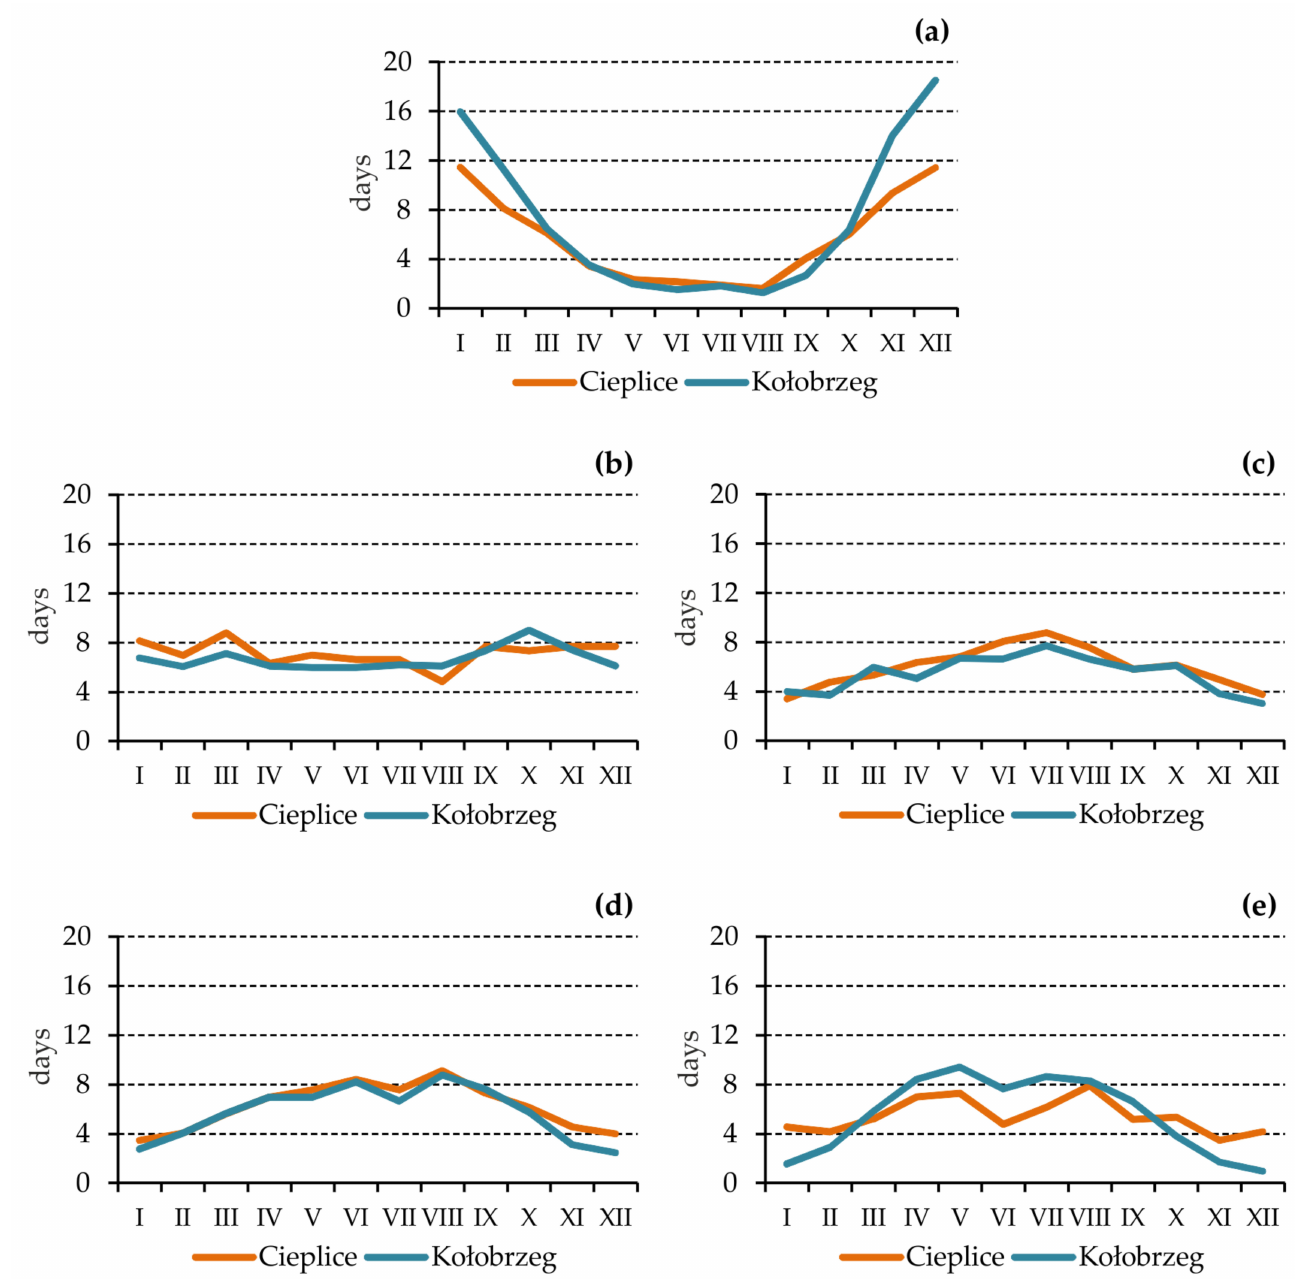
Figure 6. The annual course of the number of days for 5 classes of relative sunshine duration in Cieplice and Kołobrzeg. Average values for the years 1996–2015: ( a )—sunless days, ( b )—cloudy days, ( c )—moderately sunny days, ( d )—sunny days, ( e )—very sunny